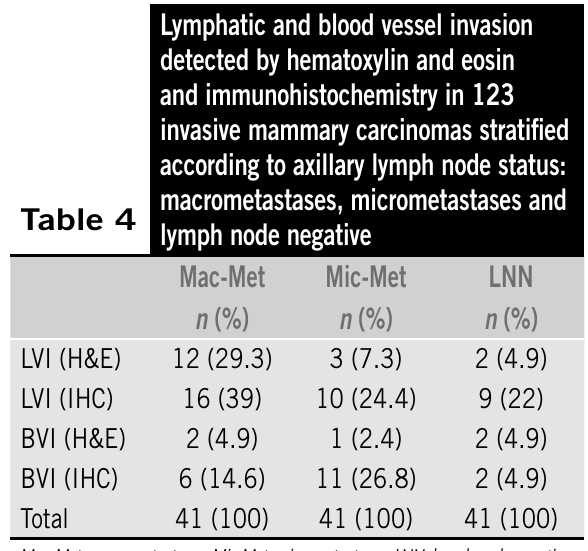
Lymphatic vessel invasion detected on hematoxylin and eosin and